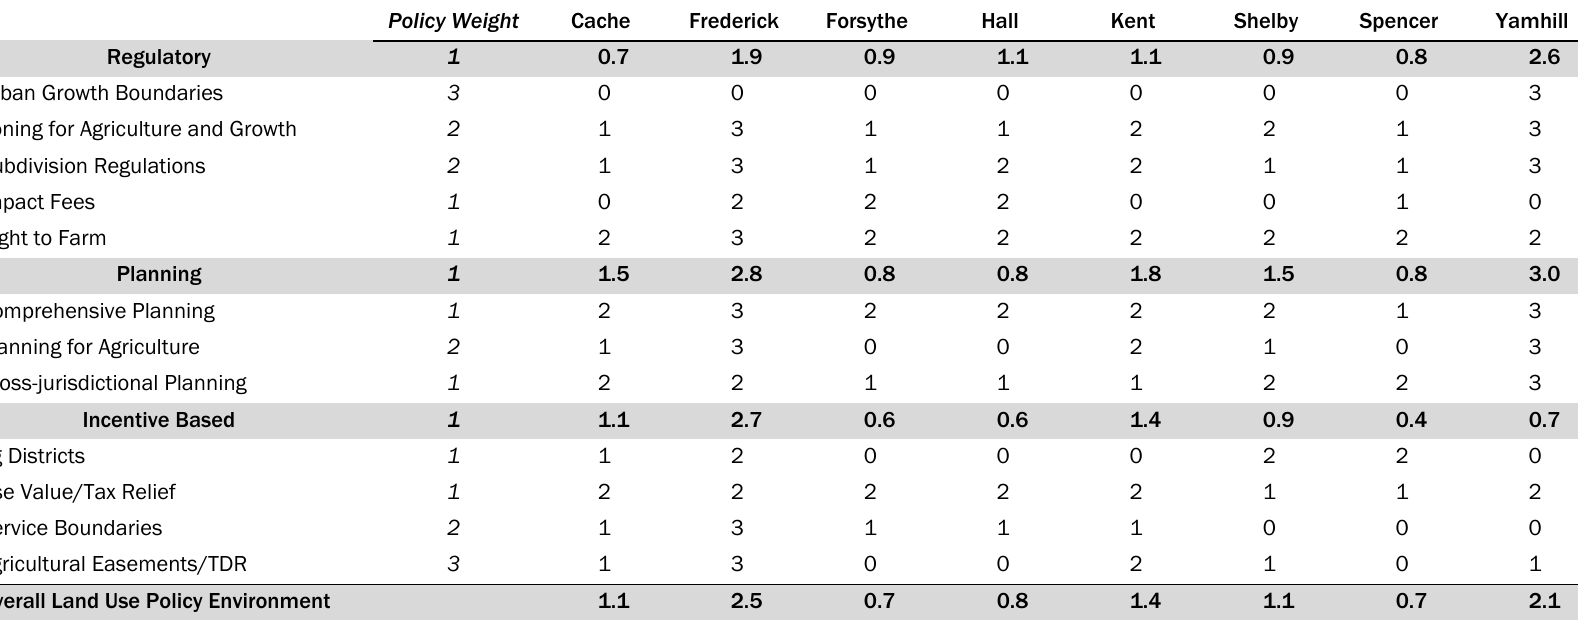
Cross-jurisdictional